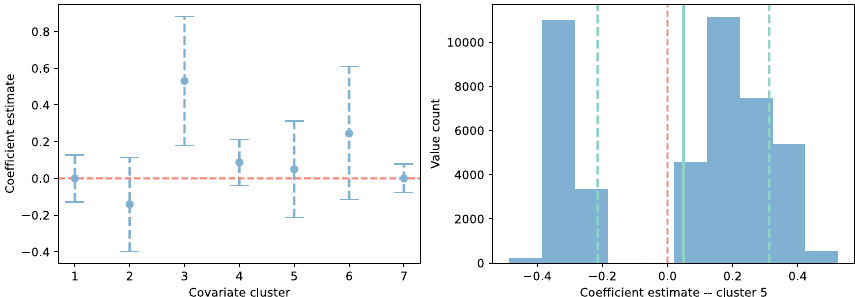
Fig. 9 Stability analysis under perturbations of the model specification; linear regression. Left panel: blue dots represent averages of the coefficient estimates obtained changing the covariates considered in each group, with ± 1 standard deviation bands (dashed blue vertical lines). The horizontal red dashed line marks 0. Right panel: distribution of the coefficients estimates associated to covariates from group 5. While 0 (dashed vertical red line) is within 1 SD (dashed vertical blue lines) from the average (solid vertical blue line), the distribution is bimodal with a trough about